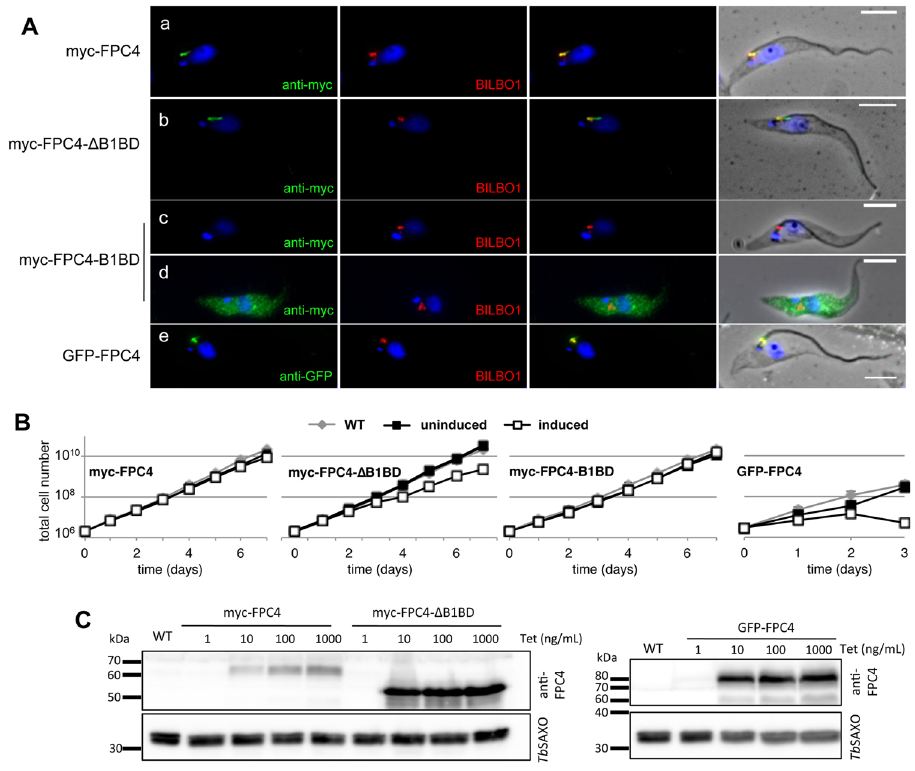
Fig 5. The B1BD of FPC4 is not involved in the targeting to the FPC/hook complex. (A) Immunofluorescence on cell lines over-expressing (48h of induction) myc-FPC4 (a), myc-FPC4- Δ B1BD(b), myc-FPC4-B1BD (c, d), and GFP-FPC4 (24 h of induction) (e) using anti-myc or anti-GFP (green) and anti- BILBO1 (red). Immunofluorescence was done on cytoskeletons except in (d) were cells were permeabilised. Kinetoplasts and nucleiwere DAPI stained. Scale bars represent 5 μ m. Initial immunofluorescenceanalyses were performed on two individualclones. (B) Growth curves for WT cells (grey diamond), and cells non- induced(black square) or induced(white square) for the expressionof myc-FPC4, myc-FPC4- Δ B1BD,myc- FPC4-B1BD, and GFP-FPC4. Error bars represent the standarderror from 3 independentexperiments (errors bars are smaller than the data point mark). (C) Western blot analysisof the level of expressionof myc- FPC4, myc-FPC4- Δ B1BD,and GFP-FPC4 using anti-FPC4, and Tb SAXO (mAb25) as loadingcontrol. Whole cell extracts from 5.10 6 cells were loadedon 12% SDS-PAGE gels and immuno-blotted.